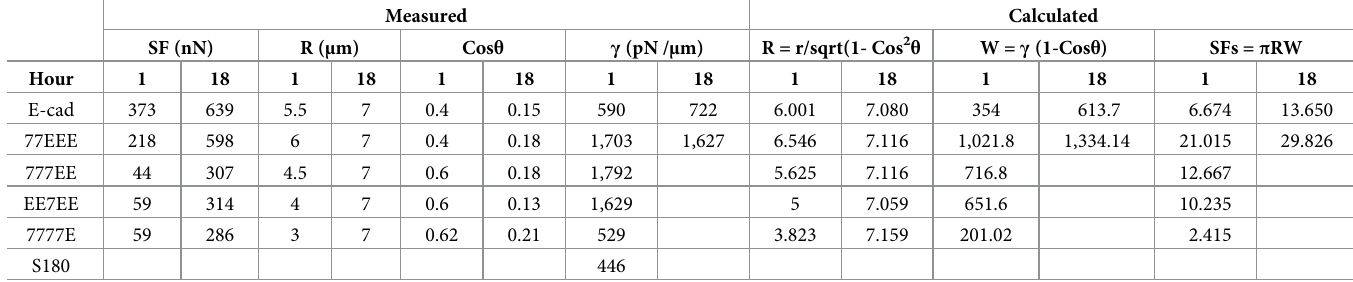
Table 1. Comparison between measured separation force and computed static separation force (SF vs SF Static ). Measured